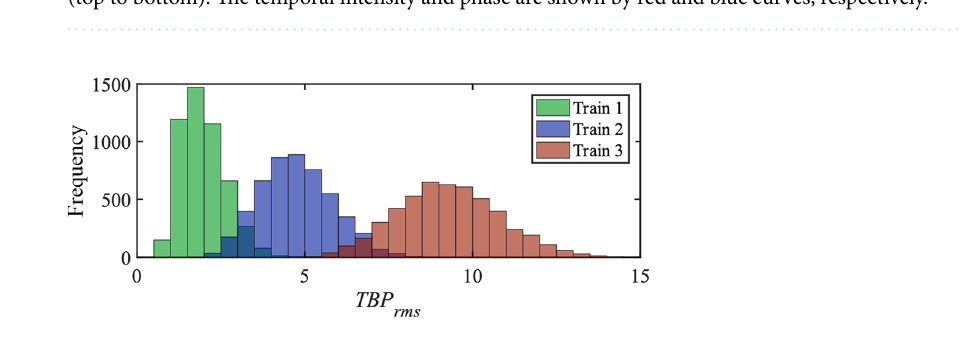
Figure 1. Samples of four pulses in the unstable trains with average FWHMs of 26, 54, and 108 fs, respectively (top to bottom). The temporal intensity and phase are shown by red and blue curves, respectively.